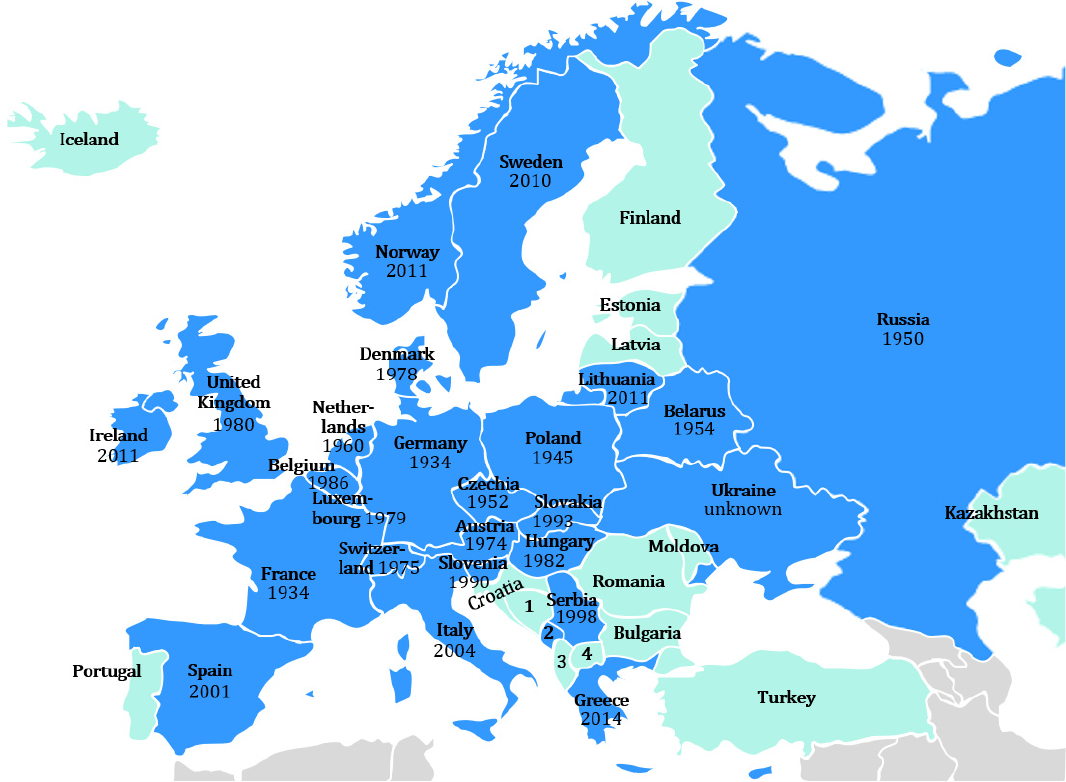
Figure 1. European distribution of raccoons (blue: raccoons detected, green: no raccoons detected, gray: non-European country, not considered). A state is defined as a distribution area of raccoons, regardless of the abundance and distribution of the raccoons within the state territory. The year indicates the first detection of raccoons in a national territory. Abbreviations: 1: Bosnia and Herzegovina, 2: Montenegro (1998), data collected before the independence of Montenegro and therefore no separation between Serbia and Montenegro, 3: Albania, 4: Northern Macedonia [3,31,34,35,42,46–53].